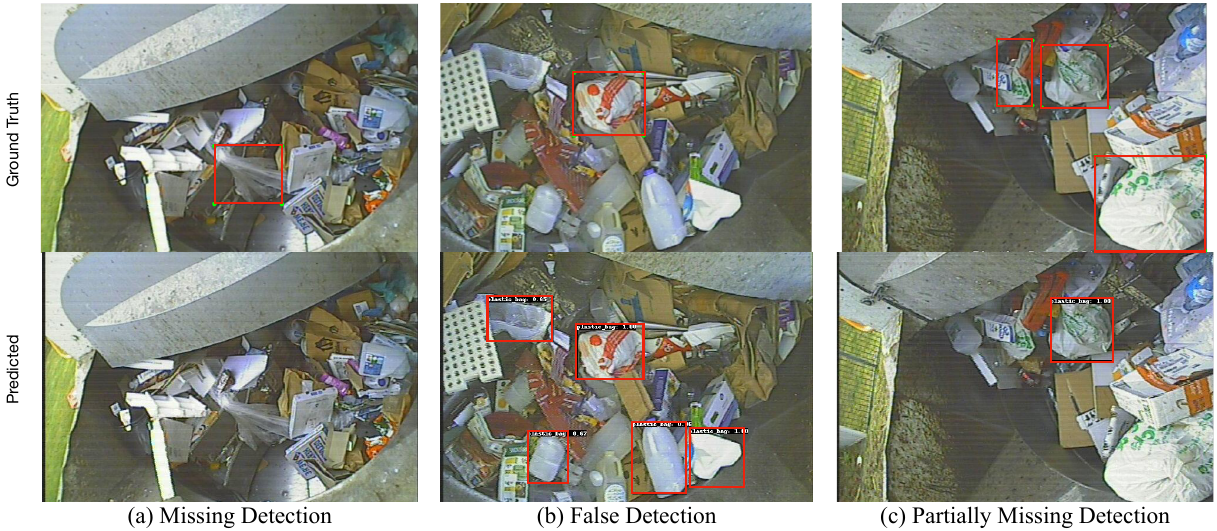
Figure 13. Sample false predictions by the YOLOv4 CSPDarkNet_tiny backbone